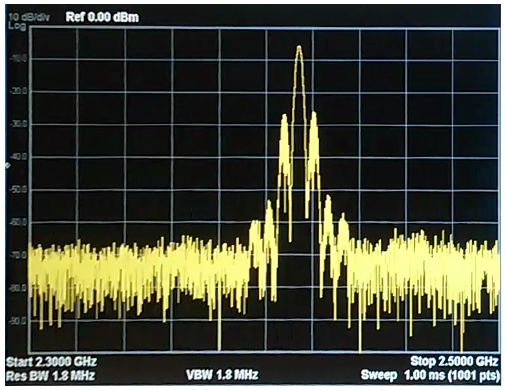
Figure 5. Radio spectrum between 2.3 GHz and 2.5 GHz with the jammer